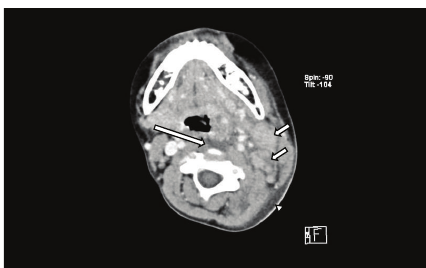
Figure 2: Postcontrast computed tomography of the neck show- ing left cervical lymph nodes swelling (arrow) with edema and increaseddensityofadjacentsubcutaneoustissuelayer(arrowhead), and retropharyngeal low density without ring enhancement (long